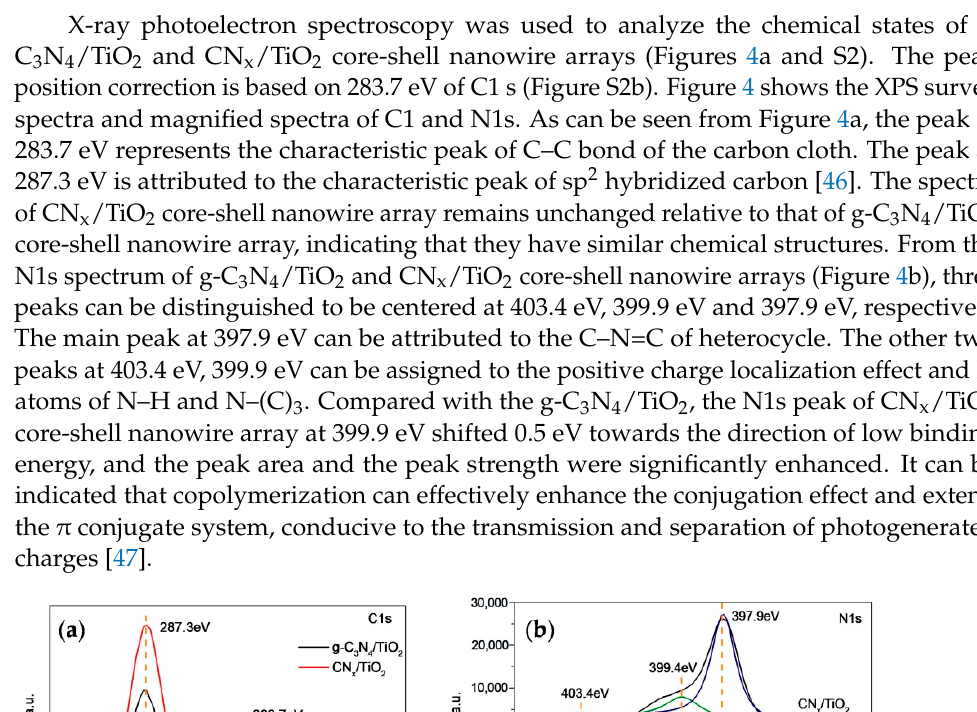
Figure 3. SEM images of ( a ) TiO 2 nanowire arrays and ( b , c ) CN x /TiO 2 core-shell nanowire arrays, ( d ) HRTEM image of CN x /TiO 2 ore-shell nanowire arrays.